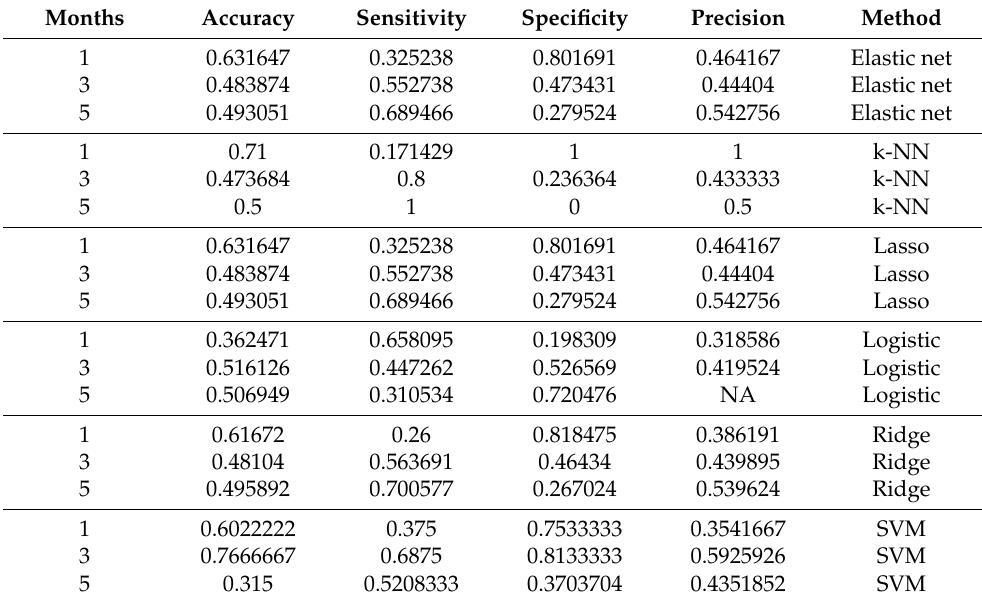
Table 4. Prediction of the response to treatment with omalizumab using 5 different ML